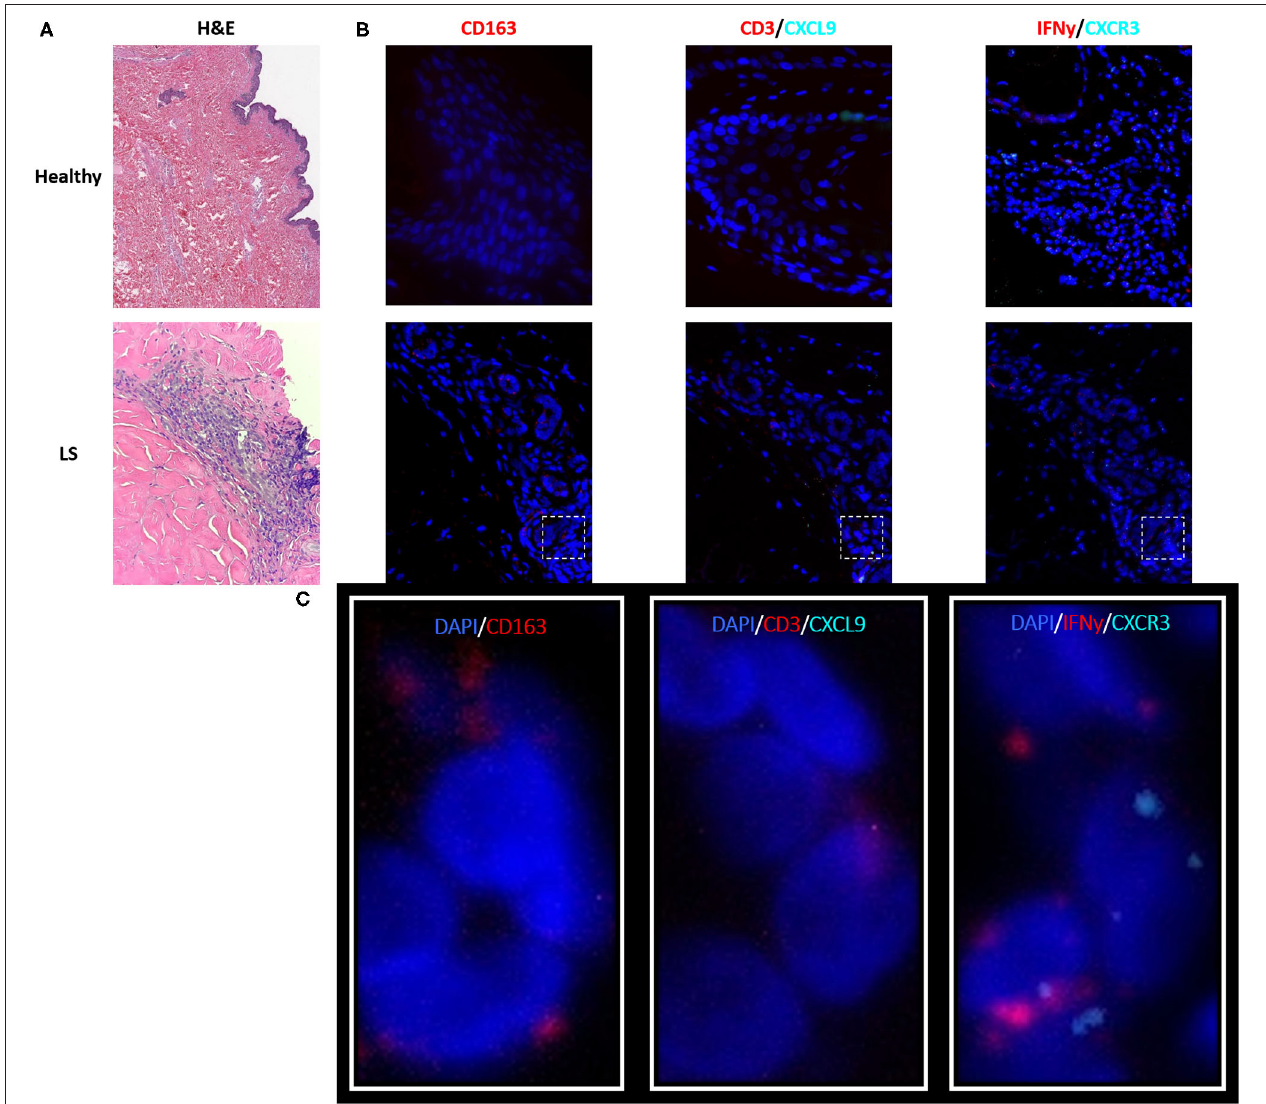
FIGURE 6 | Visualization in the skin identifies T cell and macrophage co-localization, with CXCL9 + and IFN γ + macrophages adjacent to CXCR3 + T cells in localized scleroderma (LS) skin. (A) H&E demonstrates inflammatory infiltrate extending into the lower reticular dermis in LS while the healthy sample demonstrates basal levels of minimal inflammatory cells that are typically localized to periadnexal structures. (B) RNAscope ® fluorescent multiplex imaging showed increased macrophages (CD163 + ), CXCL9, and IFNy transcript in LS skin as compared to controls. (C) Macrophage-specific (CD163 + ) CXCL9 and IFN γ staining in close approximation to CXCR3 + T